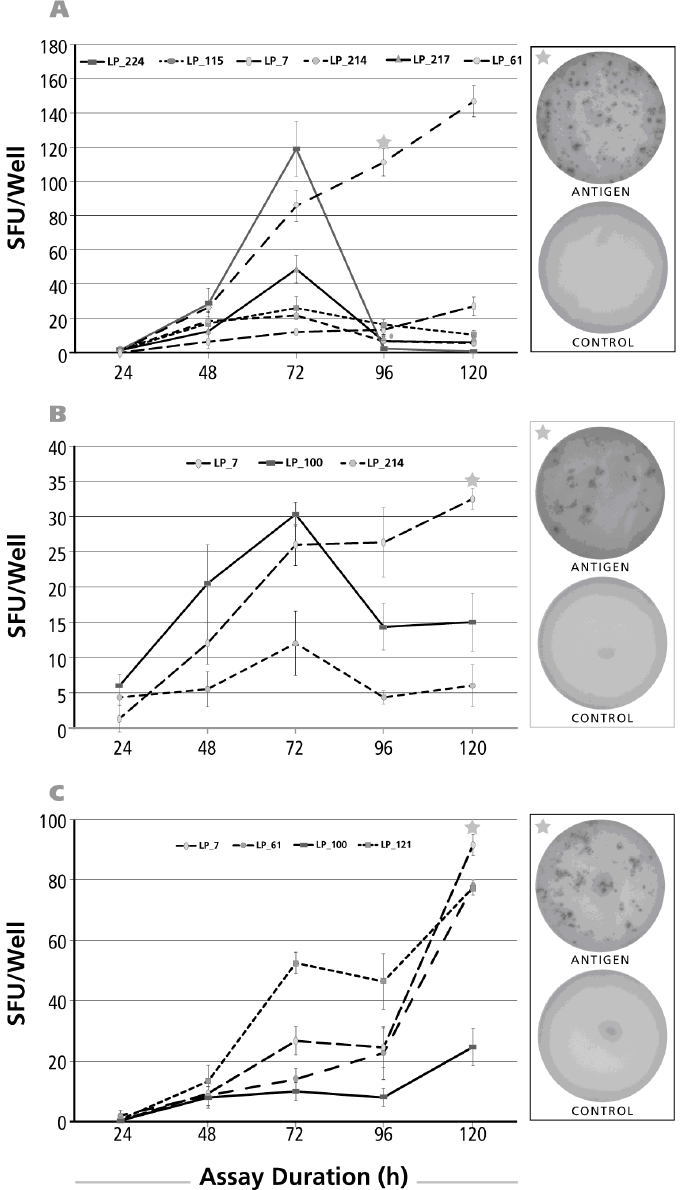
Figure 3. Kinetics of the IL-5 recall response by Th2 cells. The legend to Figure 2 applies, except that an IL-5 ELISPOT assay was done with donors and antigens that scored positive for IL-5. In Panel ( A ) CMV gr.2 was used as the recall antigen to activate IL-5 producing T cells; in Panel ( B ), PPD-triggered IL-5 production is shown; and in Panel ( C ) dust mite was used to stimulate T cells.